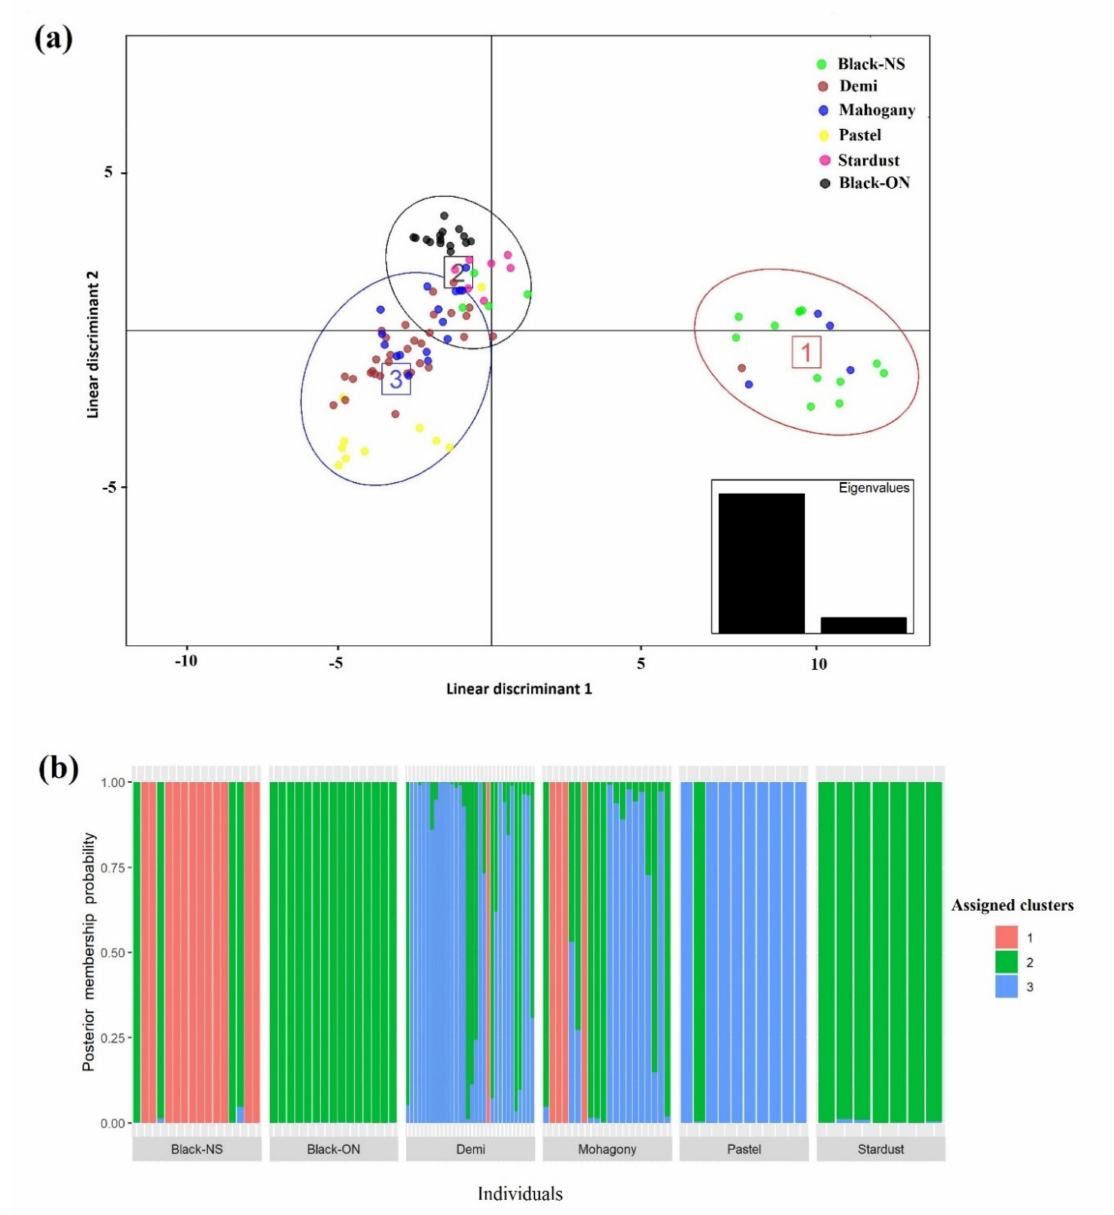
Figure 1. Discriminant analysis of principal components (DAPC) of five color-types of American mink: ( a ) The scatter plot of the first two linear discriminants for all samples. Color-types are presented by different colors and the three main clusters are shown by circles and numbers. The first two linear discriminants explained 89.68 and 10.32% of the variation, respectively; ( b ) The probability of membership of each sample in the three assigned clusters inferred by DAPC. Black-NS and Black-ON represent the black color-type samples collected from the Canadian Center for Fur Animal Research (Truro, NS, Canada) and Millbank Fur Farm (Rockwood, ON, Canada),